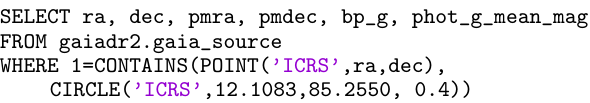
dec.” To the right of each line are two small arrow